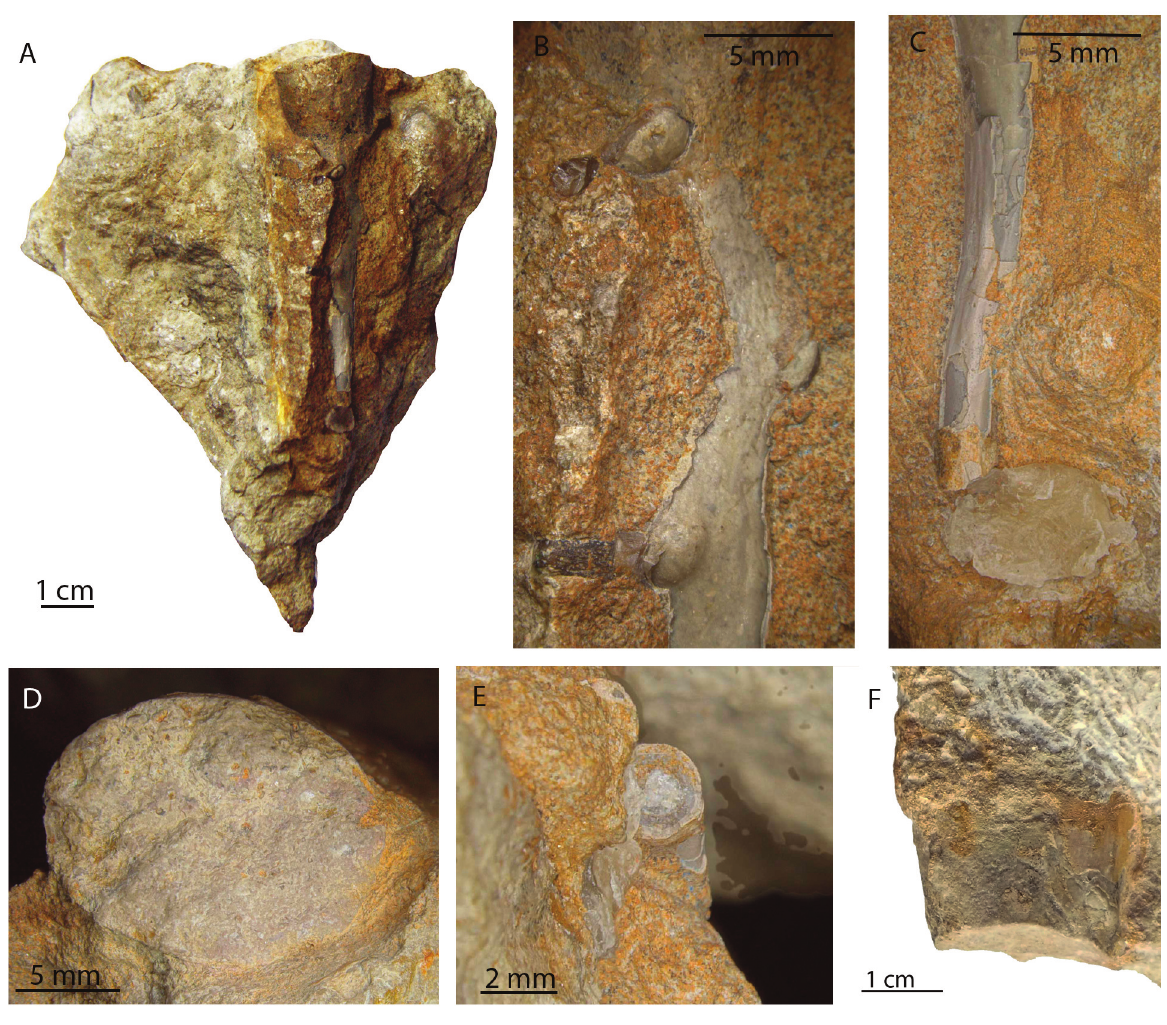
Fig. 3. Martsaphyton moxi gen. et sp. nov. A–E , holotype TUG 1303­1: A, complete specimen; B, C, details from the side view; D , view from above; E, view from below. F , fragment of the specimen, broken from the uppermost part of the holotype (TUG 1303­2), side